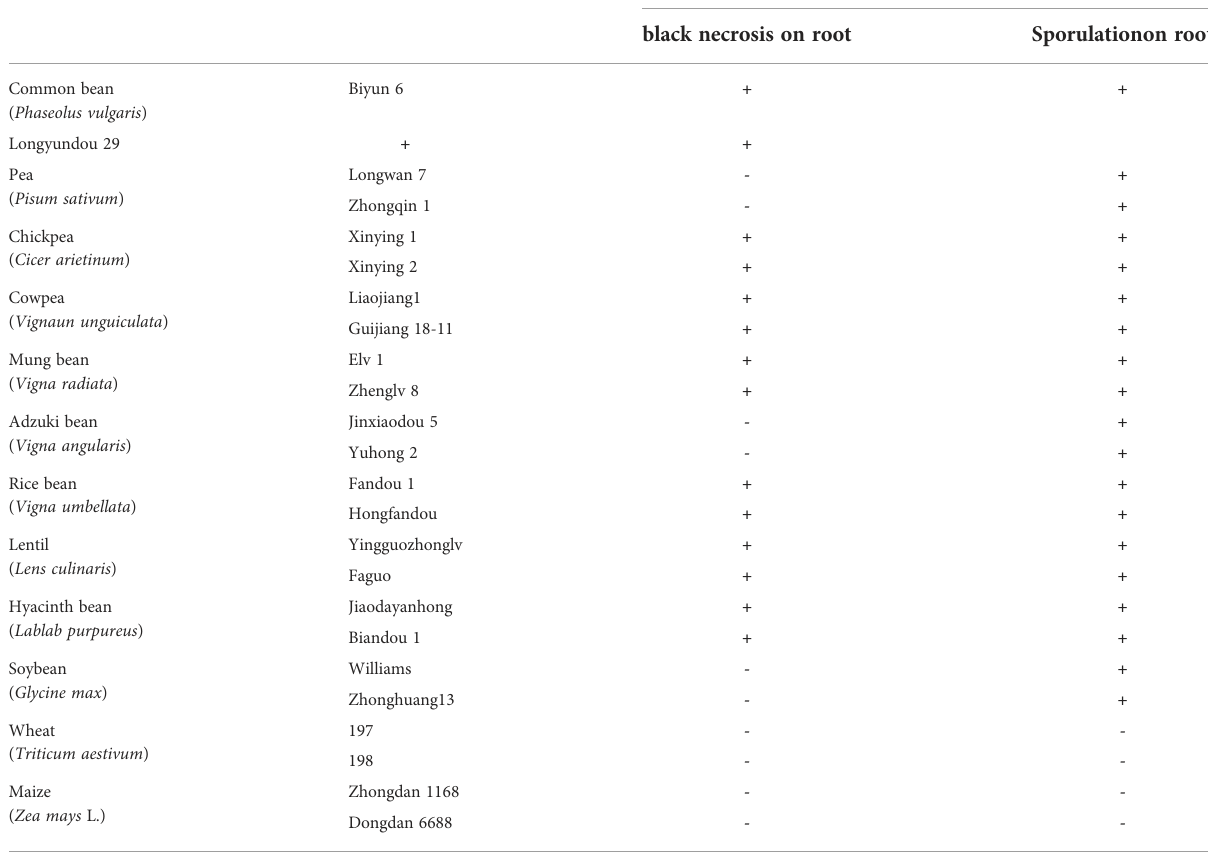
TABLE 1 Host range test of Berkeleyomyces rouxiae isolate from faba